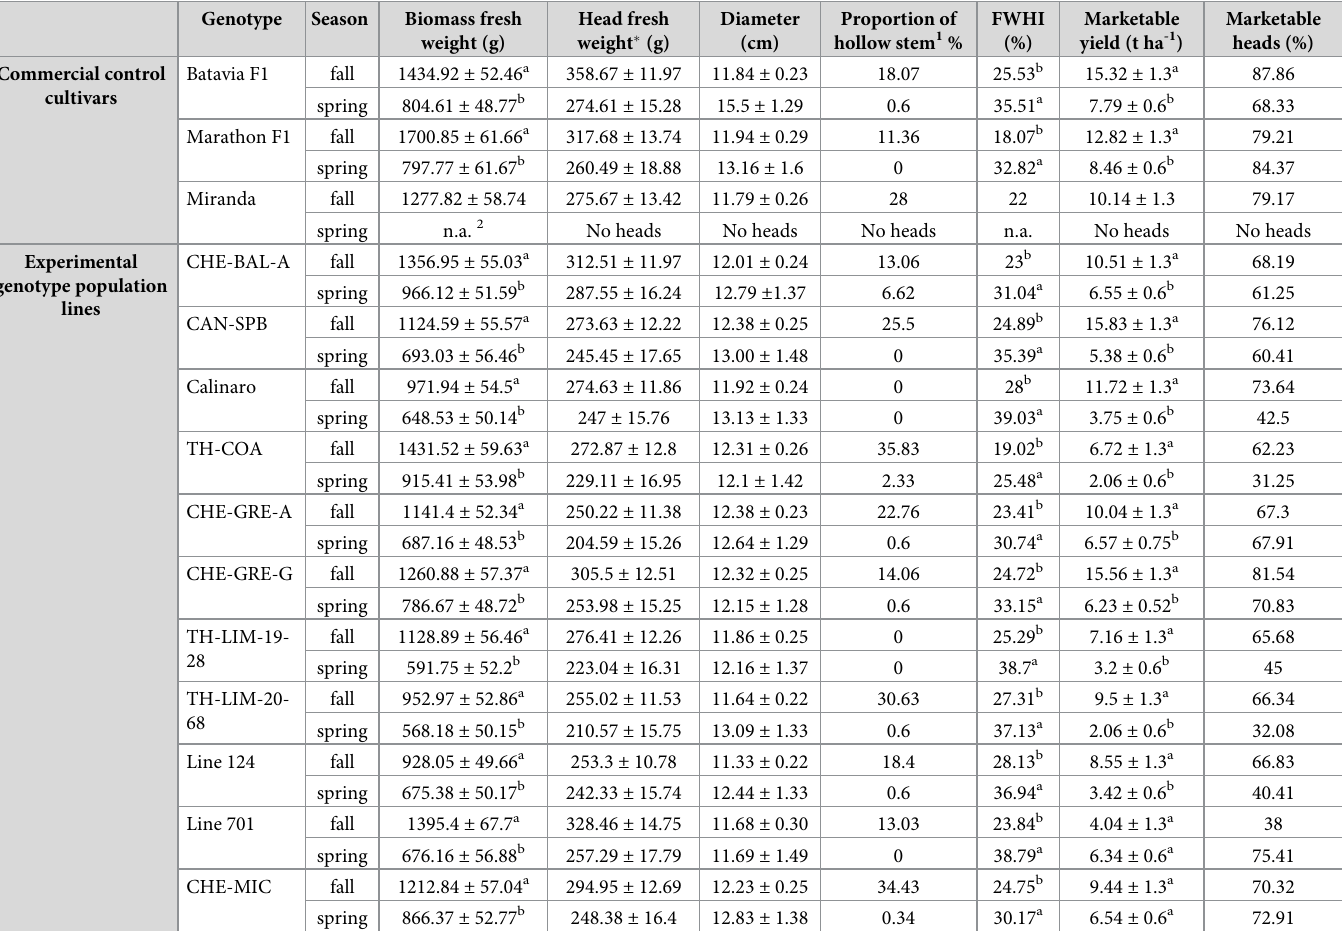
Table 1. Comparison of biomass fresh weight (g), head fresh weight (g), Diameter (cm), proportion of hollow stem (%), Fresh weight harvest index (FWHI %), mar- ketable yield (t ha -1 ) and share of marketable heads of broccoli samples within fall 2015 and spring